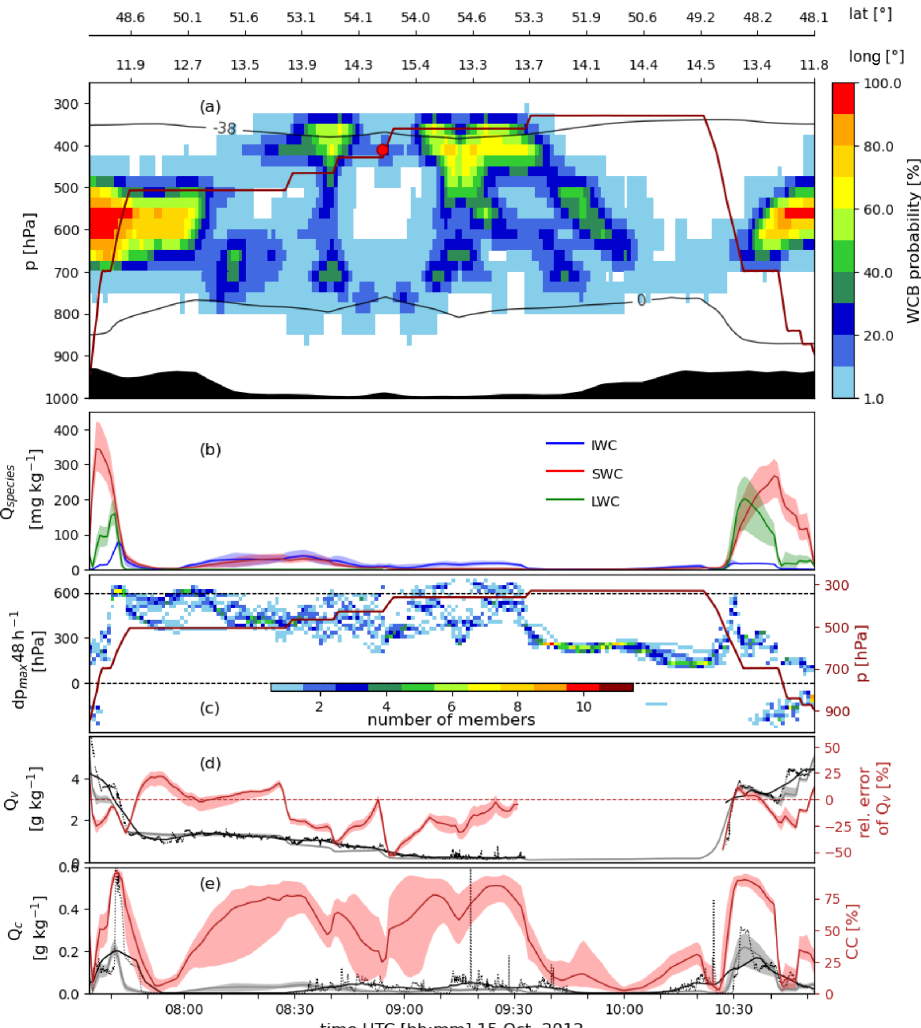
Figure 4. Time series of measurements and interpolated EDA fields along the Falcon flight IOP2b from 07:34 to 10:52UTC on 15 Octo- ber 2012. (a) WCB probabilities (colours, in %) in the vertical column along the flight track, pressure of the aircraft altitude (dark red line, in hPa) and EDA mean temperature (0 and − 38 ◦ C, black lines); (b) EDA cloud species (see legend, in mgkg − 1 ); (c) maximum pressure decrease (ascent) within 48h of the air parcels that were measured during the flight, calculated for each EDA member (left y axis) and, as in panel (a) , flight altitude (in hPa, right y axis); (d) specific humidity Q v (in gkg − 1 ) from in situ measurements (black line for 5min running mean and native resolution as dots) and from EDA (grey line for mean and shading between minimum and maximum EDA values), with relative error of the EDA members compared to the measurements 100 · (Q EDA − Q v )Q − 1 v (red line and shading, right y axis); and (e) cloud condensate Q c (in gkg − 1 ) from in situ measurements (black line and dots as in panel d ) and EDA consisting of liquid and ice water content (grey), and EDA cloud cover (red, right y